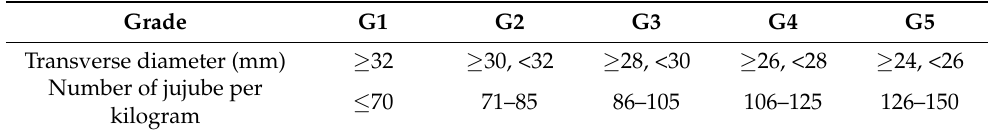
Table 1. The grading standard of dried